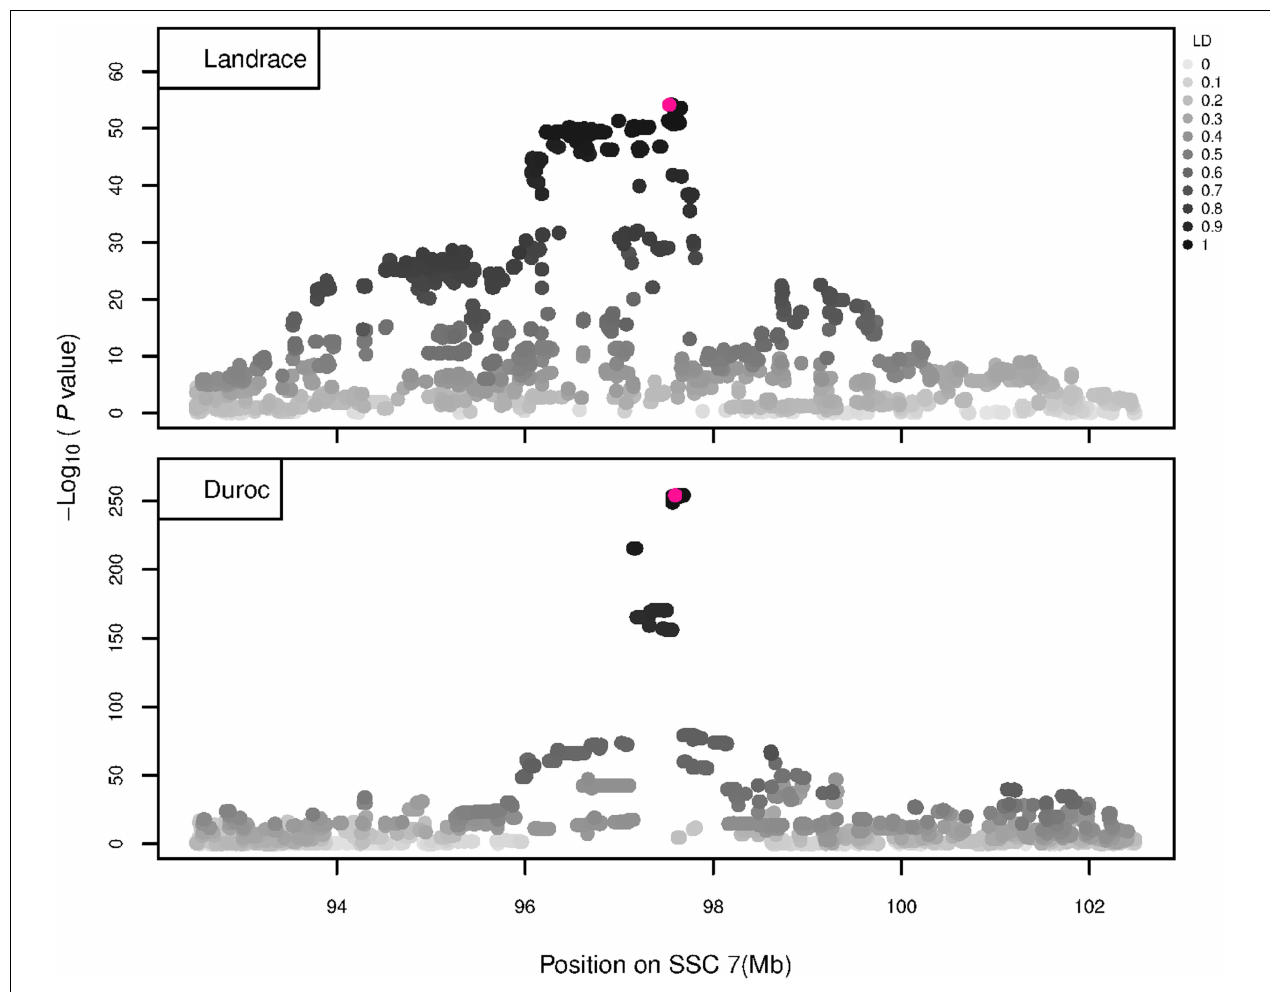
FIGURE 7 | GWAS plot for RIB using imputed whole-sequence data. On the y -axis is the –log 10 ( p -values) of single SNP association with RIB in L and D breeds. On the x -axis is the physical position of the SNP in the SSC7 QTL region. Linkage disequilibrium (LD) is given in a scale of 0–1 as a measure of the pairwise correlation between the most significant SNP (pink dot) and all other